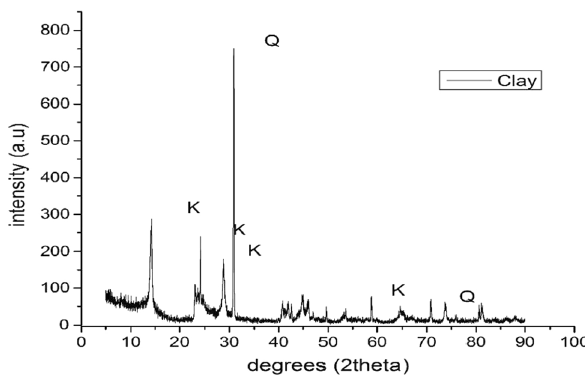
3 O 4 and Fe 3 O 4